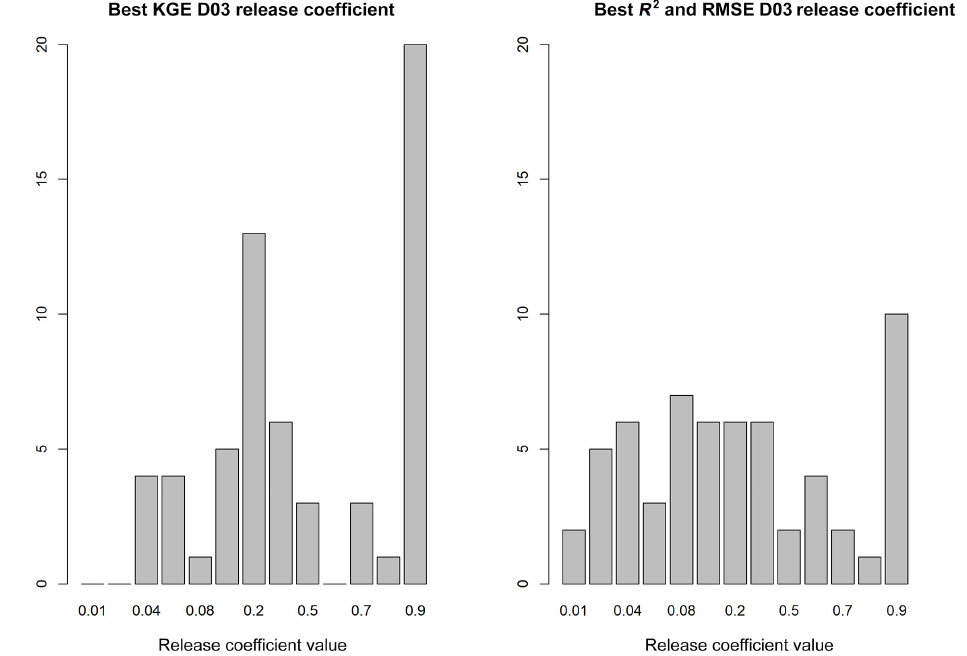
Figure 6. Bar charts of k rd values that maximize KGE and correlation and minimize